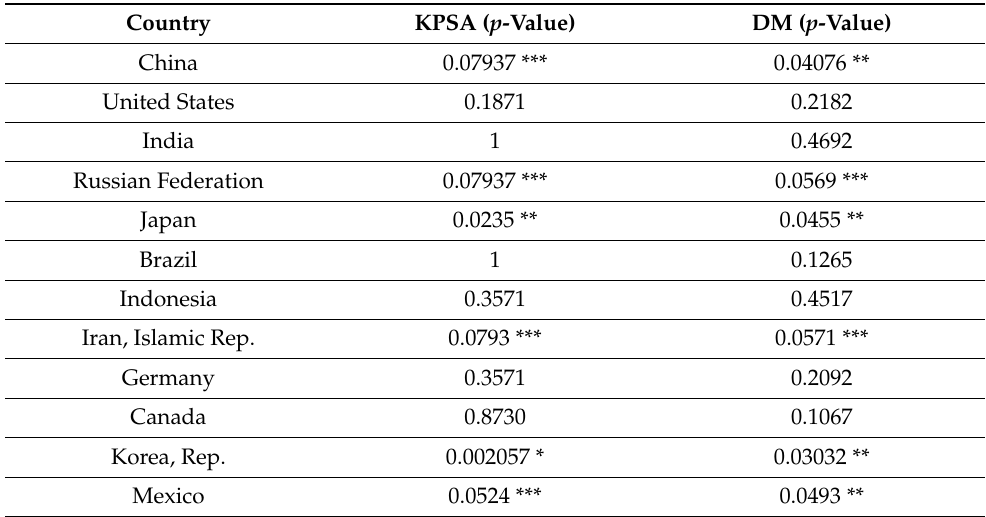
Table 4. Results of the KSPA and DM tests ( p